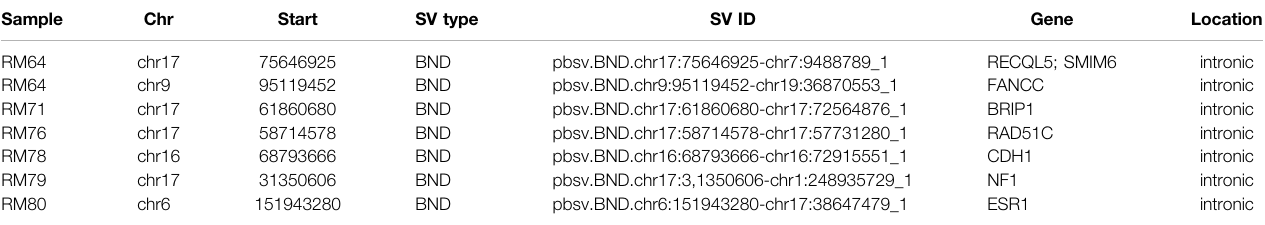
TABLE 2 | Fusion genes detected in tumor samples. Sample